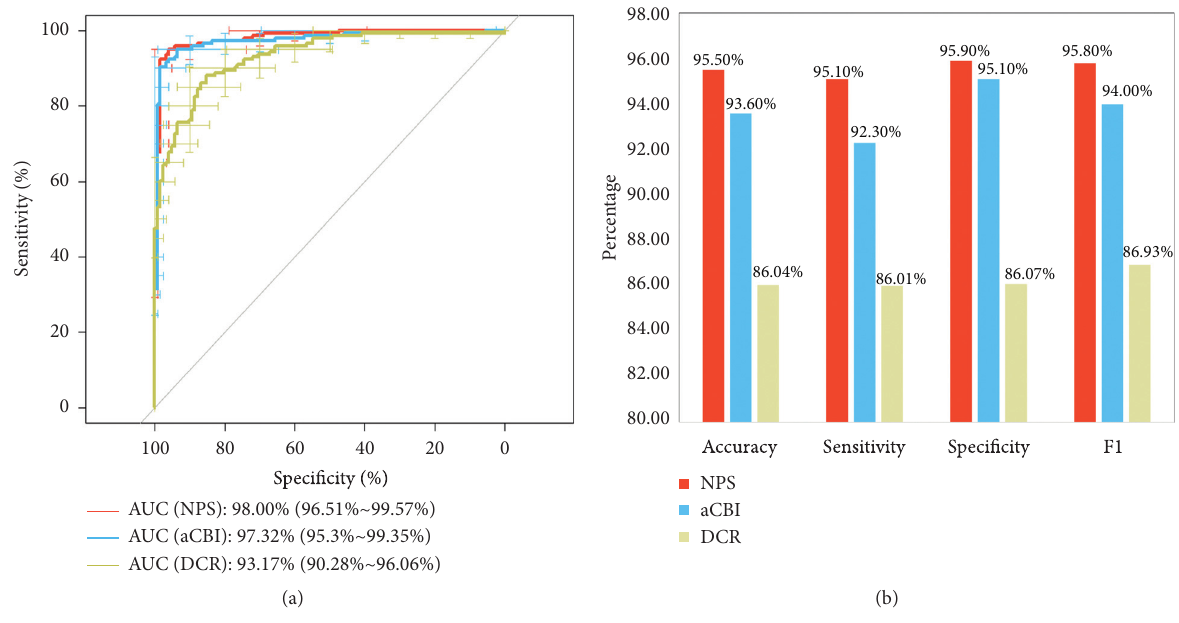
Figure 3: Representative graphs for ROC curves (a) and four evaluation indicators (accuracy, sensitivity, specificity, and F1) (b) of NPS, aCBI, and DCR in combined (145 keratoconus and 122 normal eyes)